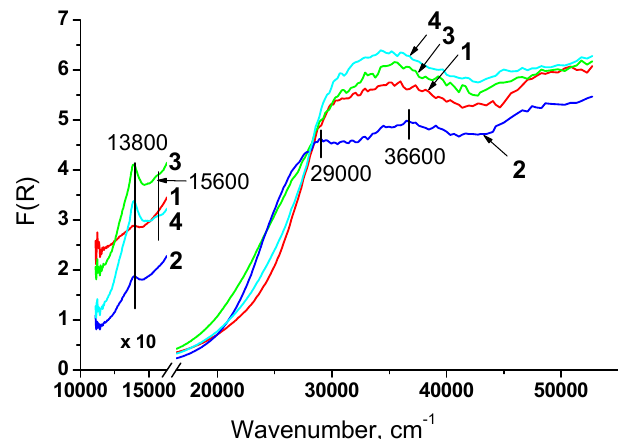
Figure 7. UV-Vis spectra of samples prepared by citrate methods: 1 – Ni-CeZr, 2 – Ni-CeNbZr, 3 – Ni-CeTiZr, 4 – Ni-CeTiNbZr.